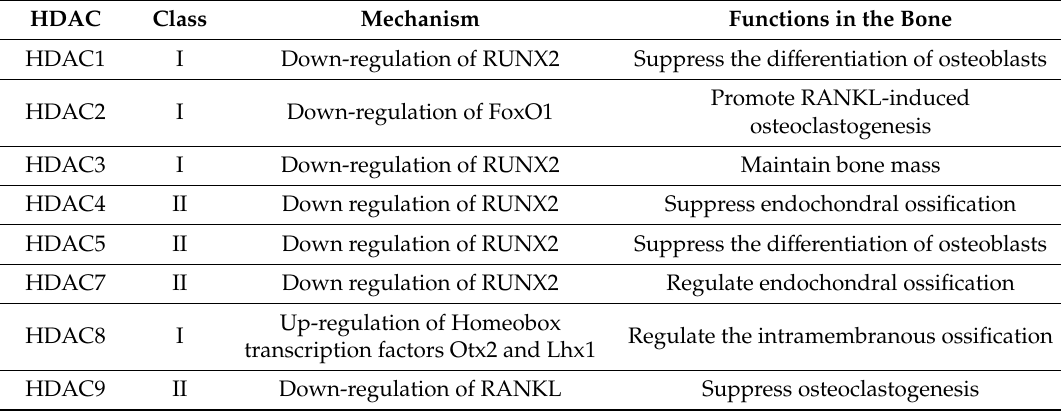
Table 1. The role of histone deacetylase (HDACs) in